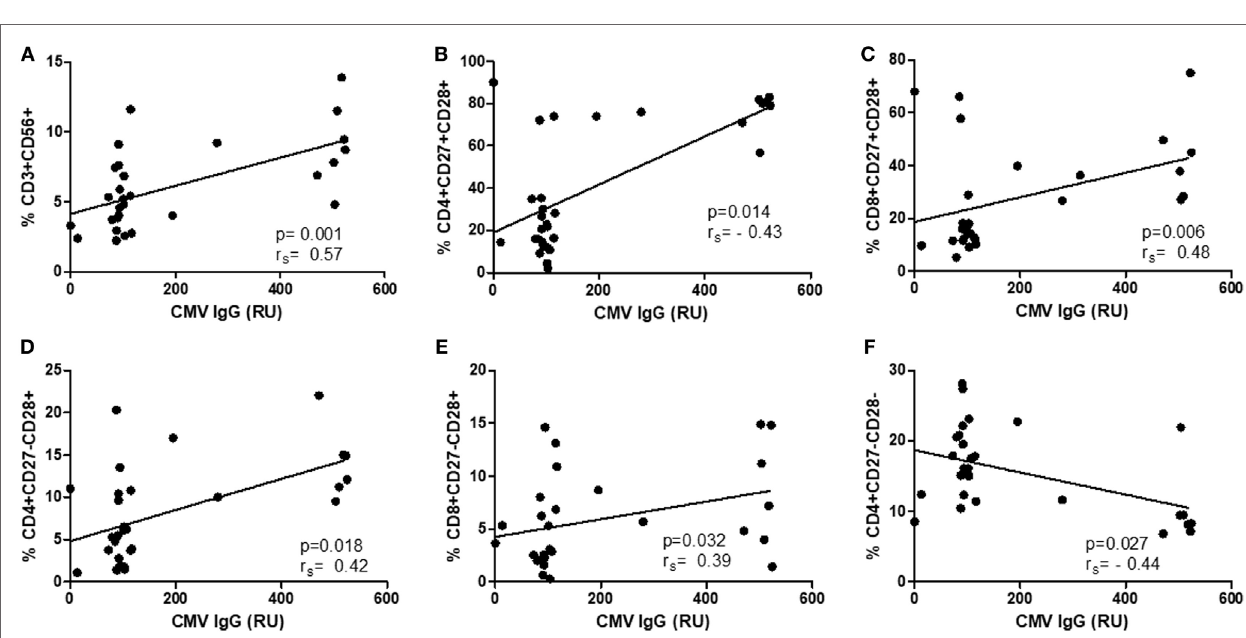
FigUre 5 | Correlation between IgG anti-cytomegalovirus (CMV) titers and immunosenescence markers in healthy controls. (a–F) Show the correlation between CD3 + CD56 + ( r s = 0.57, p < 0.001), CD4 + CD27 + CD28 + ( r s = 0.43, p = 0.01), CD8 + CD27 + CD28 + ( r s = 0.49, p = 0.06), CD4 + CD27 − CD28 + ( r s = 0.42, p = 0.01), and CD8 + CD27 − CD28 + ( r s = 0.39, p = 0.03) and anti CMV–IgG titers.